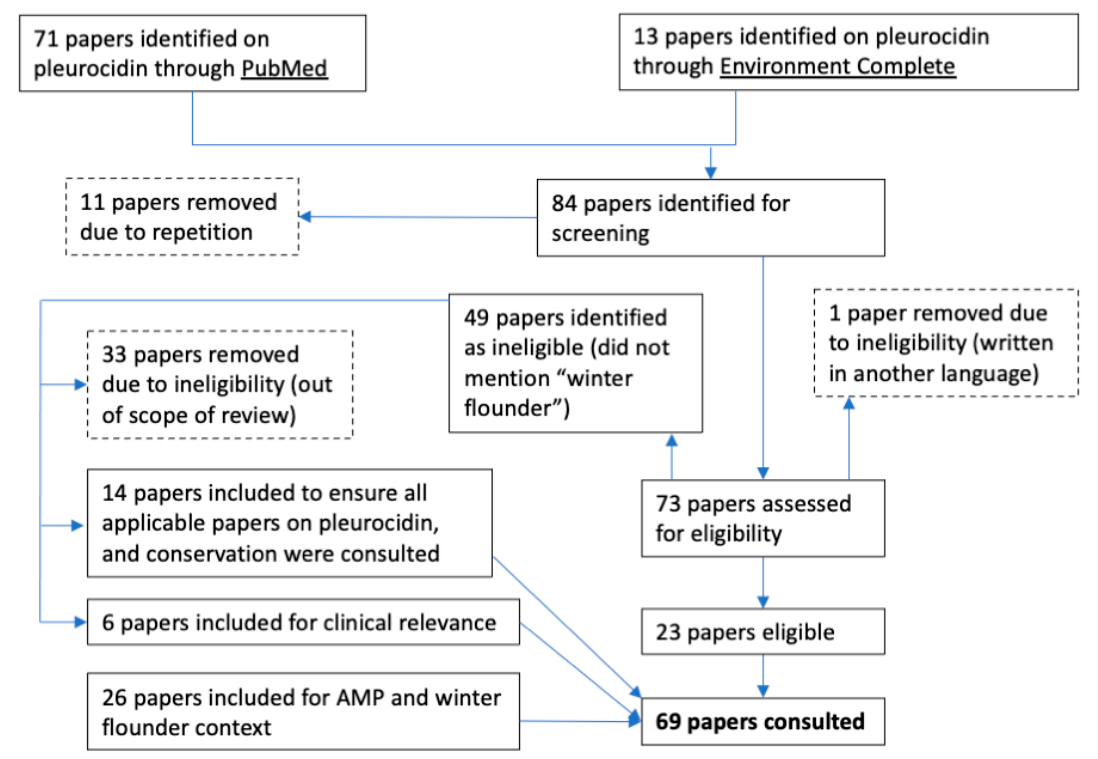
Figure 1. PubMed and Environment Complete diagram of papers included in the review of pleurocidin.